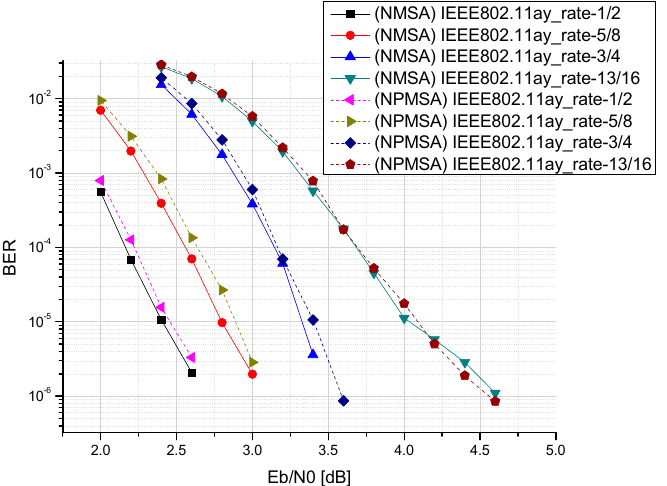
Figure 13. Comparison of decoding performance of different algorithms in IEEE 802.15.3c.